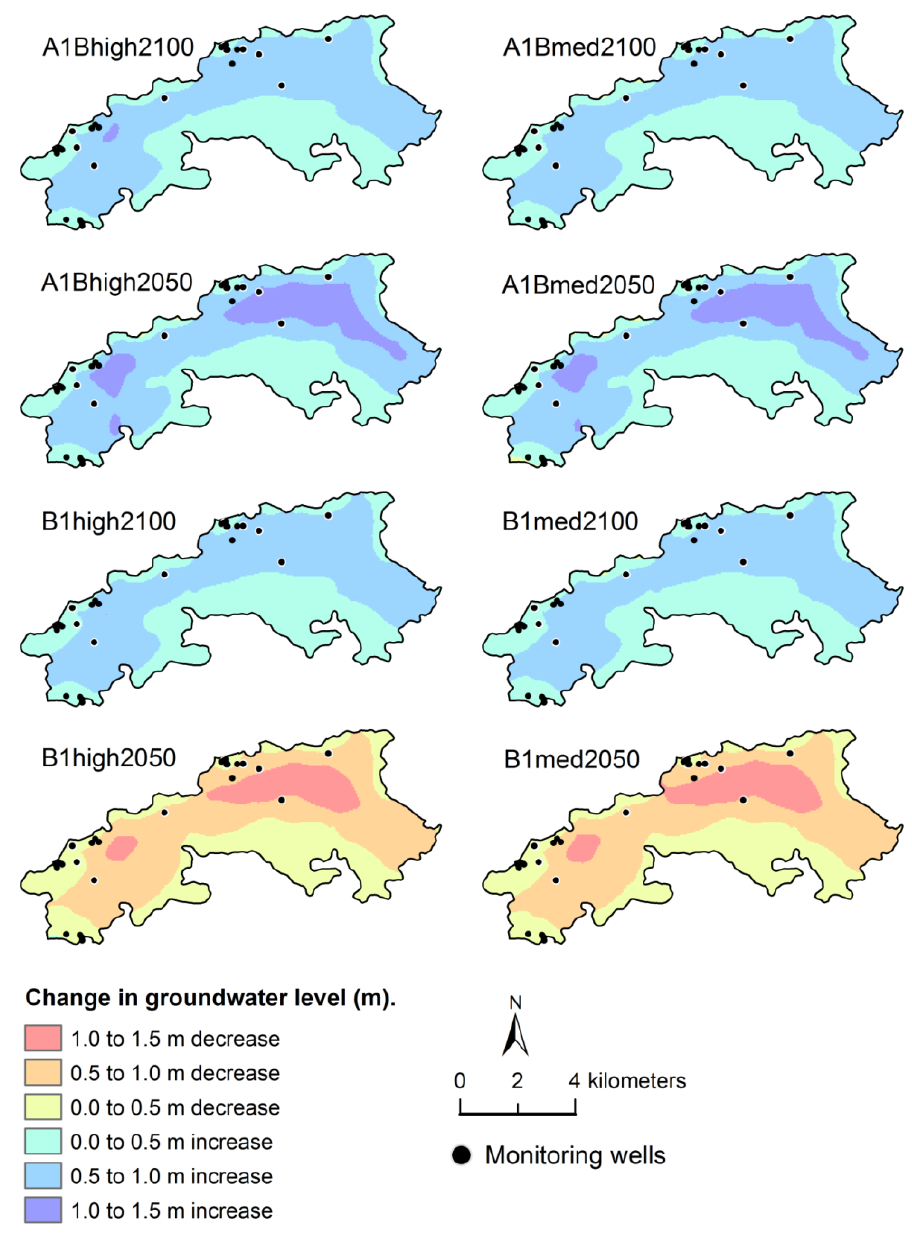
Figure 14. Spatial distribution of changes in groundwater level for climate scenarios A1B and B1 and their high and medium (med) sea level scenarios during the periods 2021–2050 and 2071–2100 compared with present